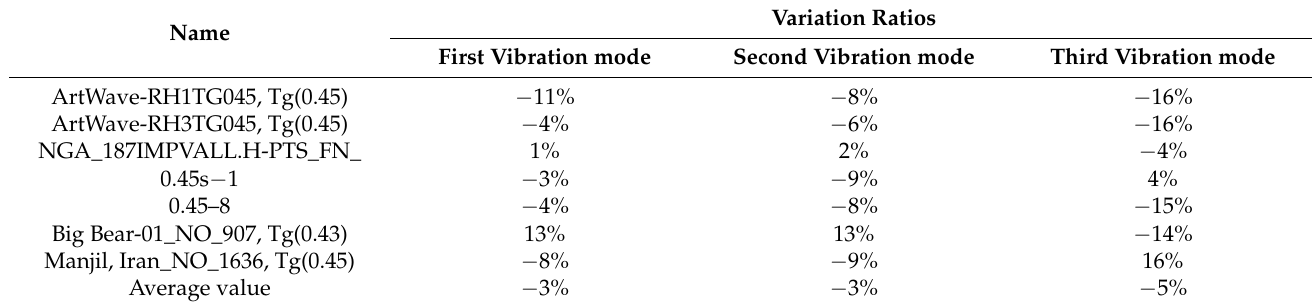
Table 10. Variations in the period ratios of the seven ground-motion waves.